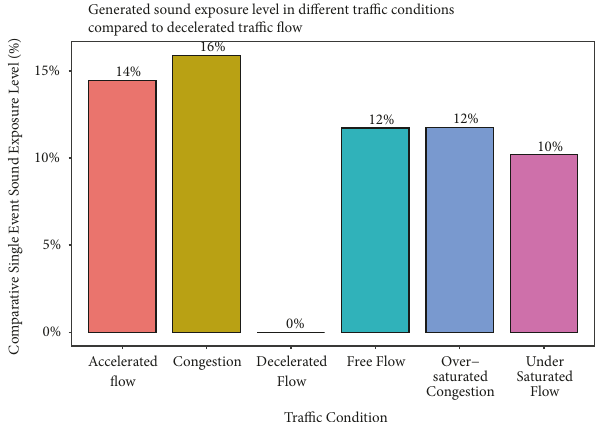
Figure 5: Comparing generated single event sound exposure levels in different traffic